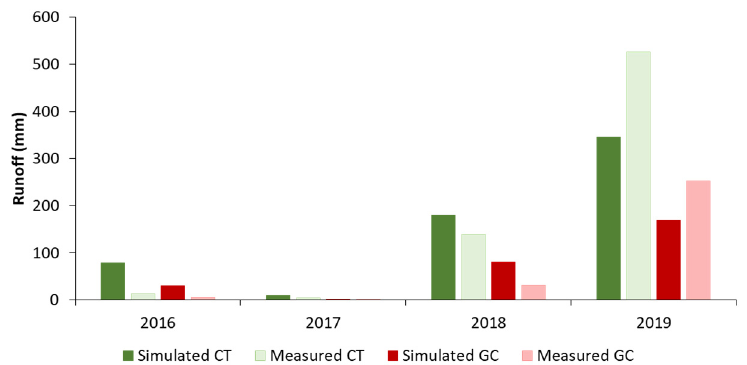
Figure 6. Simulated and measured seasonal runoff in the Monferrato plots with conventional tillage (CT) and grass cover (GC).